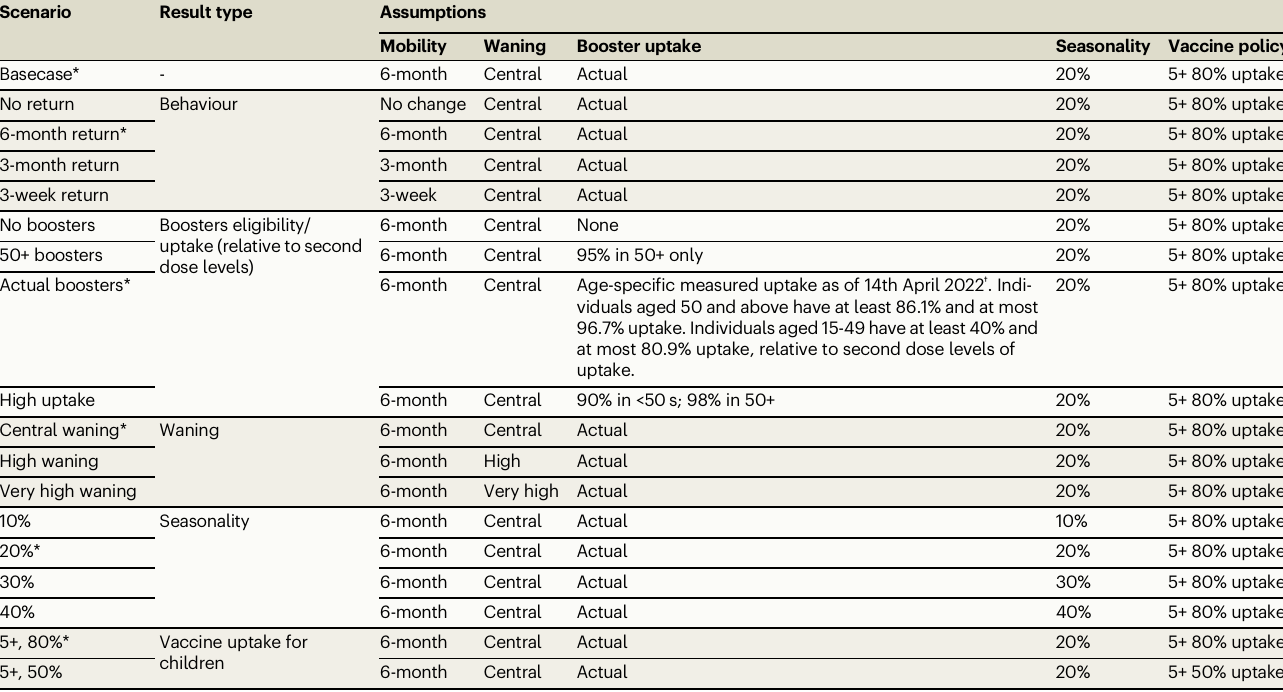
Table 1 | List of modelling scenarios and key assumptions